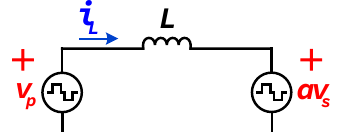
Figure 2. Lossless model, referred equivalent model of the primary side of the DAB dc-dc